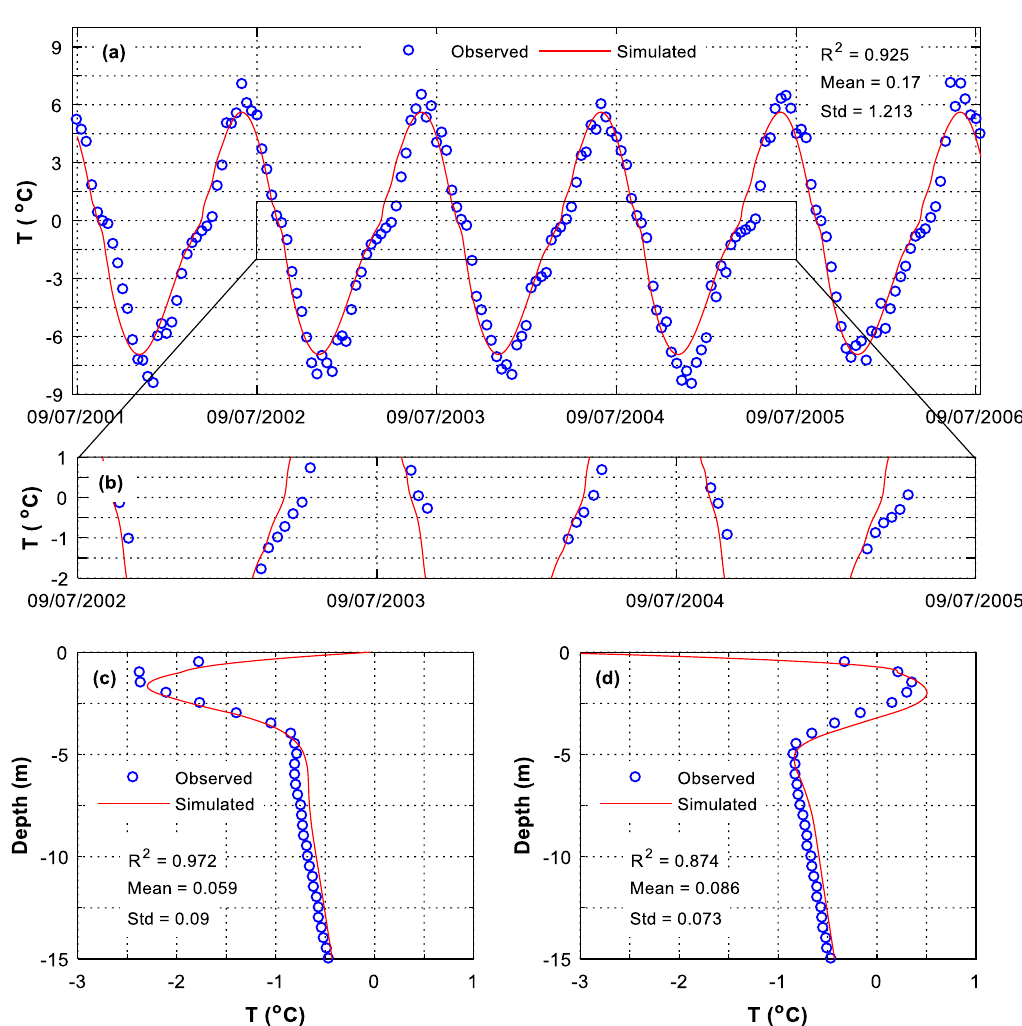
Figure 4. Soil temperatures predicted by TCM. Location: at the natural borehole that is 20 m away from the side-slope toe. ( a ) Temperature serial at 0.5 m depth, with R 2 = 0.925, Mean = 0.17 °C and Std = 1.213 °C, ( b ) temperature serial at 0.5 m depth, ( c ) on April 20, 2002, and (d) on October 19,